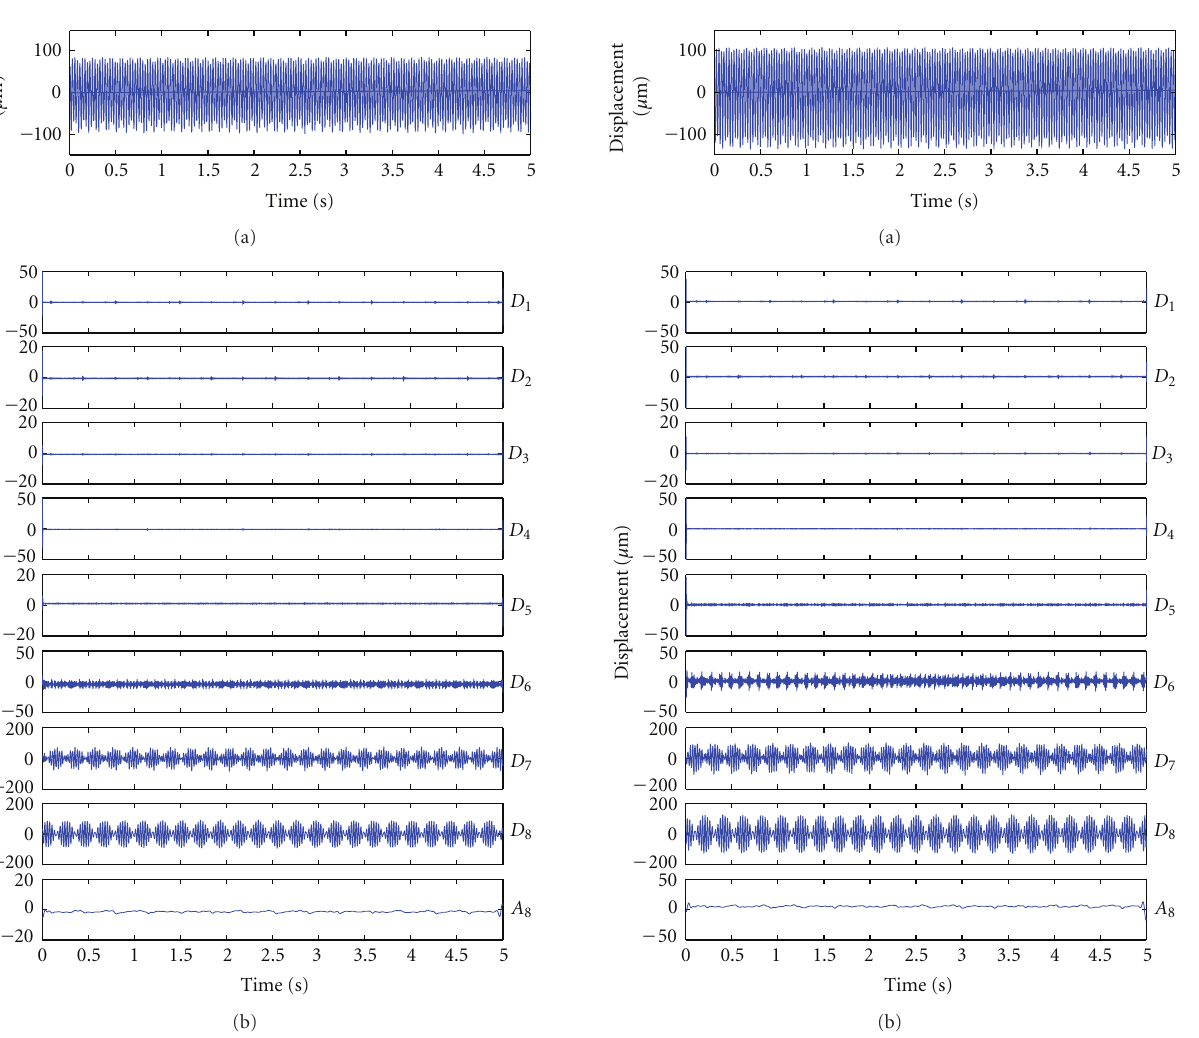
are measured by displacement sensors located at node 15 (see Figure 2(a)). It is apparent from Figures 4(b) and 5(b) that the most significant contributions to the signal come from the three lowest-frequency bands: D 6 , D 7 , and D 8 . The contributions from the other five bands, D 1 – D 5 , are negligi- ble. Note also that the amplitudes in the approximation, A 8 , which corresponds to the 0–19.53 Hz frequency band, are very small. The calculated rms values of the amplitudes in the three bands D 6 – D 8 are listed in Table 2. It is apparent from this table that in each of these three frequency bands, the rms value of the cracked rotor is larger than that of the healthy